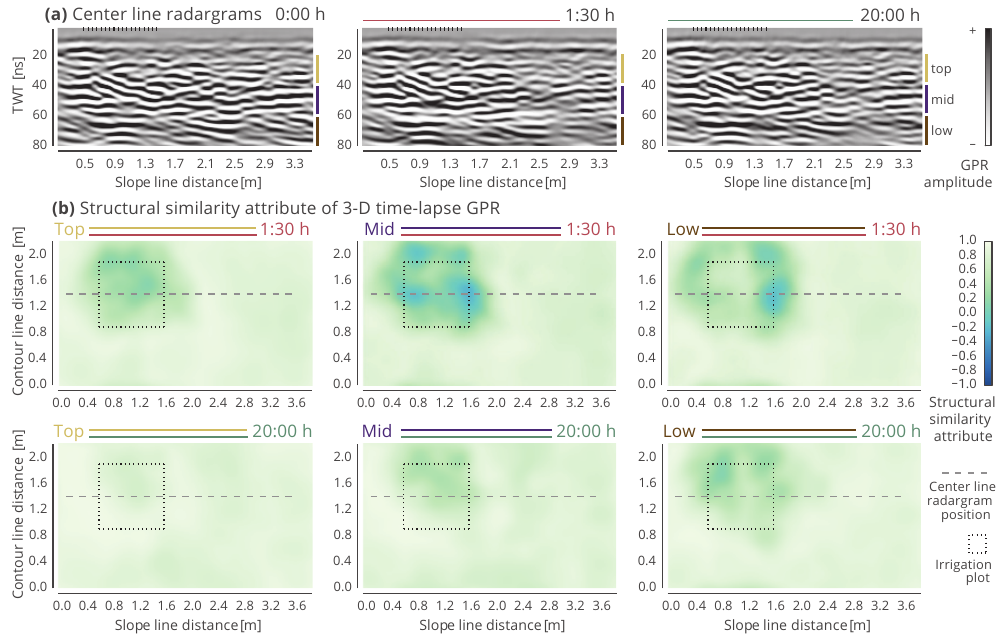
Figure D3. Time-lapse 3-D GPR of the irrigation experiment at plot XII. Center line radargrams at the marked transect (gray dashed line in the lower panels) for the three acquisition times (before 00:00h, directly after irrigation 01:30h, 20:00 h after irrigation) are given in the top row. The structural similarity attribute of the 3-D data cube is given in three different depth layers (top 20–40ns, mid 40–60ns, low 60–80ns) in the lower panels. The irrigation plot is marked by a black dashed box/line. Slope line distance is increasing downslope.